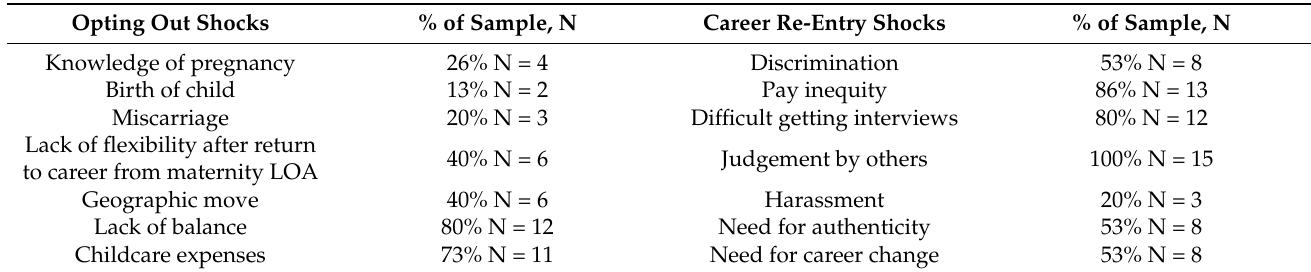
Table 4. Career Shocks (Study 2 N =